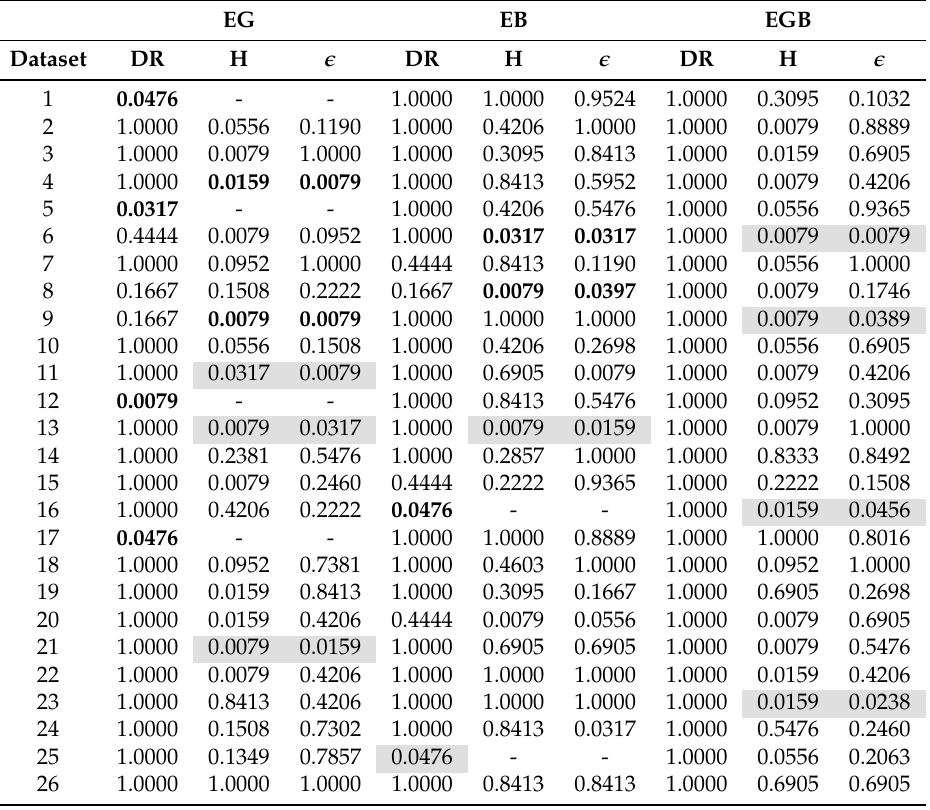
Table 5. MAMH and MAGMA multi-objective tests (same